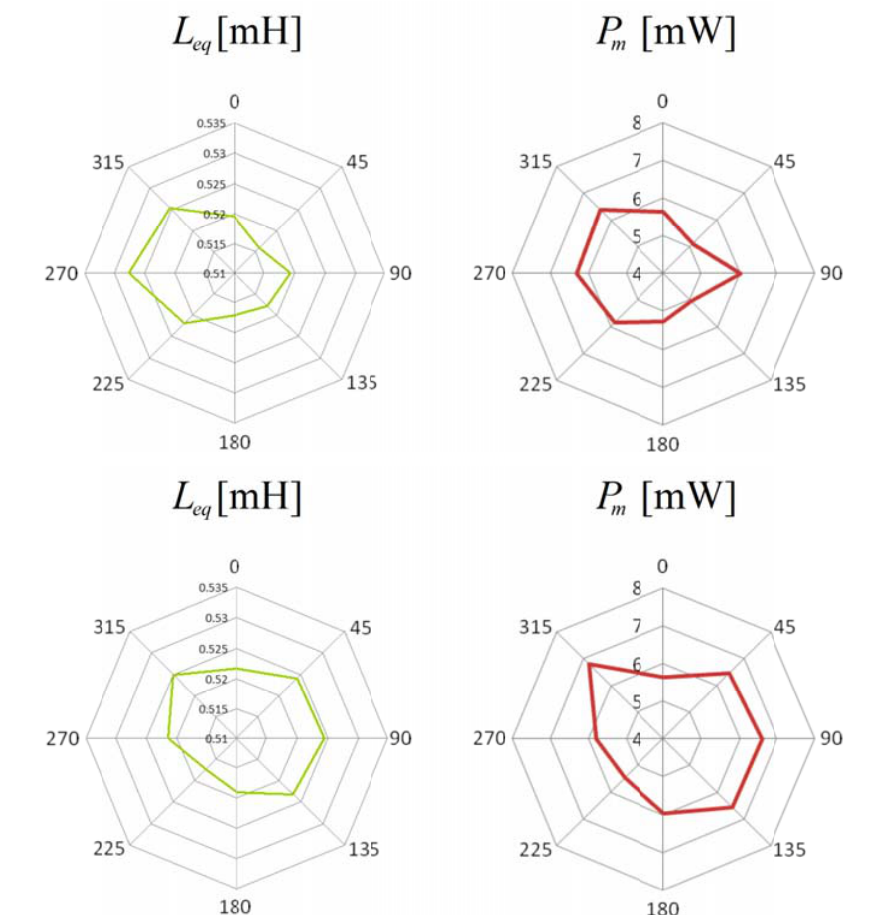
Figure e 9. Polar p plots of the self-induct ance and of magne etic field me easured on two nt